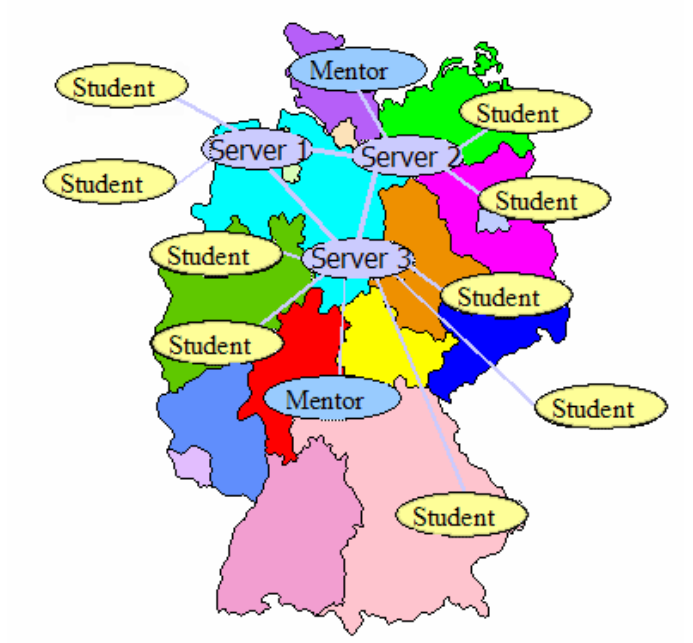
Figure 3 . Technical infrastructure of the “Virtual Study